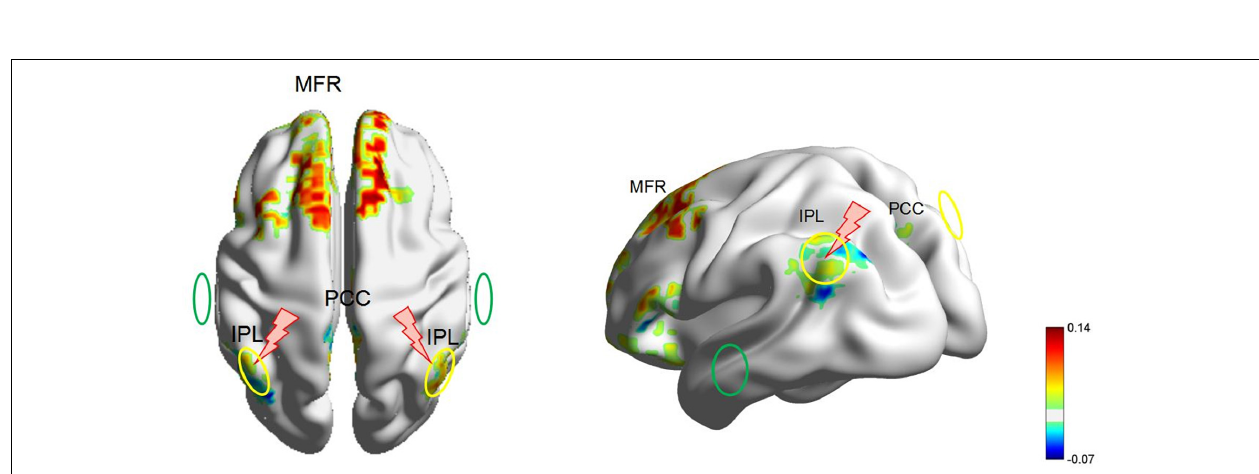
FIGURE 3 | The locations of the rTMS and tDCS targets in a head model of patient 1. The yellow circle denotes the anode electrode over P3 or P4. The green circle denotes the cathode electrode over T3 or T4. The red lightning mark denotes the rTMS site over P3 or P4. For the 20-min treatment on the right hemisphere, the anodal tDCS was delivered over P4, and the cathodal tDCS was delivered over T3. Meanwhile, 5-Hz rTMS was delivered precisely over the anodal electrode at P4. Then, for the next 20-min treatment on the left hemisphere, the anodal tDCS was delivered over P3, and the cathodal tDCS was delivered over T4. Meanwhile, 5-Hz rTMS was delivered precisely over the anodal electrode at P3. rTMS, repetitive transcranial magnetic stimulation; tDCS, transcranial direct current stimulation; fMRI, functional magnetic resonance imaging; IPL, inferior parietal lobe; PCC, posterior cingulate cortex; MFR, mesiofrontal